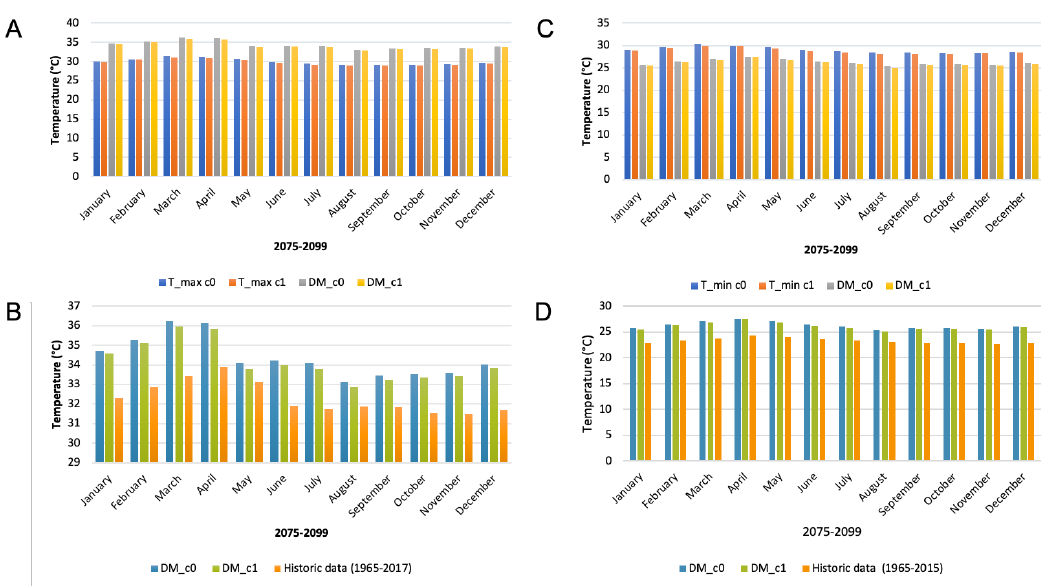
Figure 5. Comparison of the monthly temperature for projected estimates under the C0 and C1 SST-ensembles and their respective corrected counterparts: Monthly maximum temperatures ( A ), Monthly minimum temperatures ( C ). Comparison of the corrected temperature to the historical meteorological data: maximum temperatures ( B ), minimum temperatures ( D ) .